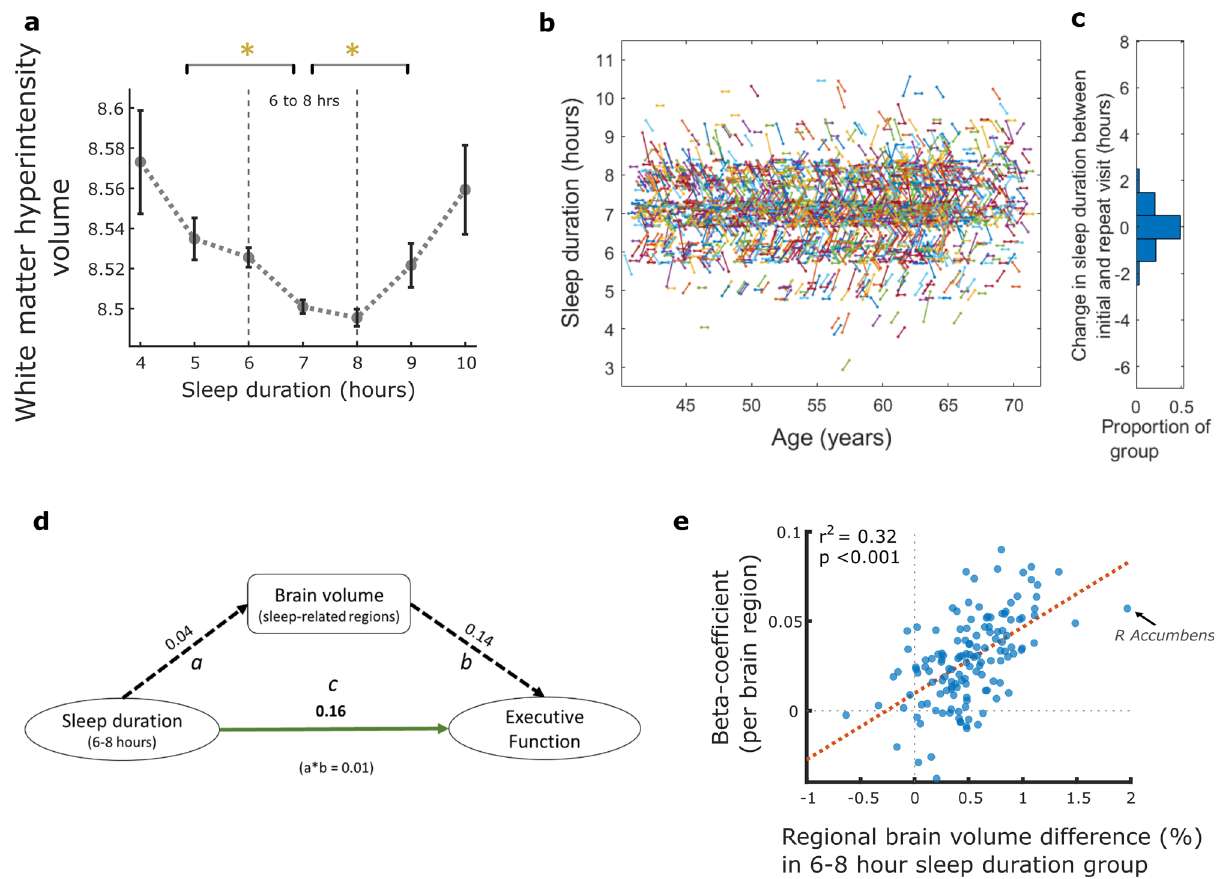
Fig. 4 White matter hyperintensity load and sleep duration, sleep trajectory and relationship between sleep duration, brain volume and Executive Function. a Association between sleep duration and white matter hyperintensity volume (WMH), log-transformed, showing the lowest WMH burden with eight hours of sleep. Those who slept for durations other than six-to-eight hours had signi fi cantly greater burden, P < 0.05 following Bonferroni correction for multiple comparison (error bars denote standard error). b Sleep trajectory plotted for a random subset of the imaging cohort (5%, n = 2,416, for visualisation purposes) who provided sleep data at two timepoints, mean 8.9 (sd 1.8) years apart. Each line represents an individual, plotted by age, with the gradient re fl ecting any change in sleep duration between initial and imaging assessments ( b : sleep axis points have been jittered by 5% to